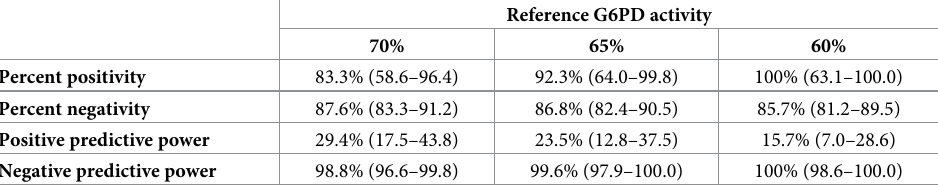
Table 5. Diagnostic performance of the 6.0 U/g Hb threshold on the STANDARD G6PD Test for females with G6PD deficient and intermediate activity on capillary specimens. The percent positivity, negativity, and predictive power for all females with > 70%, 65%, and 60% activity are shown. Ninety-five percent confidence intervals are pro- vided in brackets.